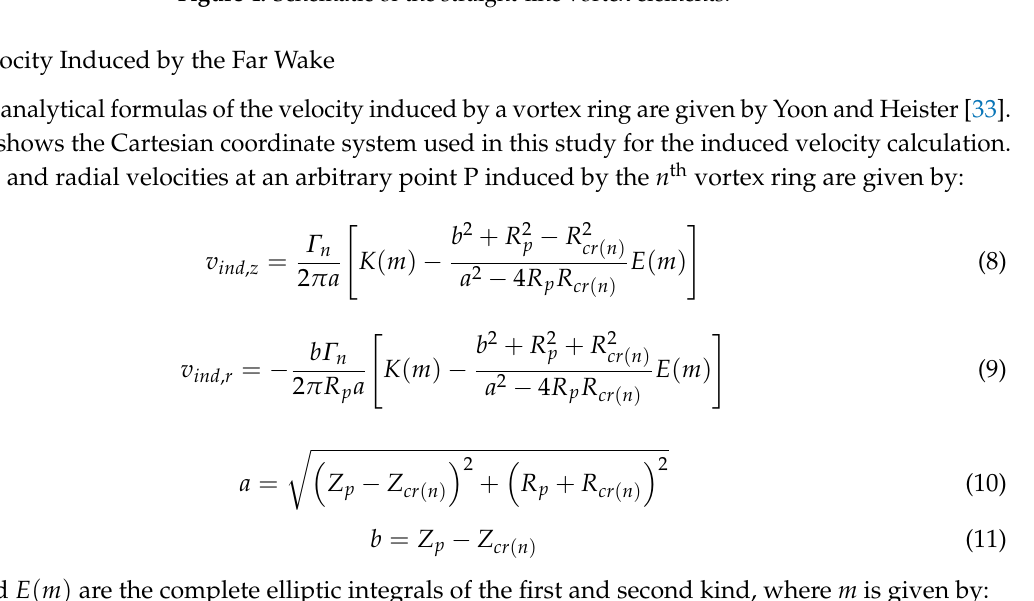
Figure 4. Schematic of the straight-line vortex elements.